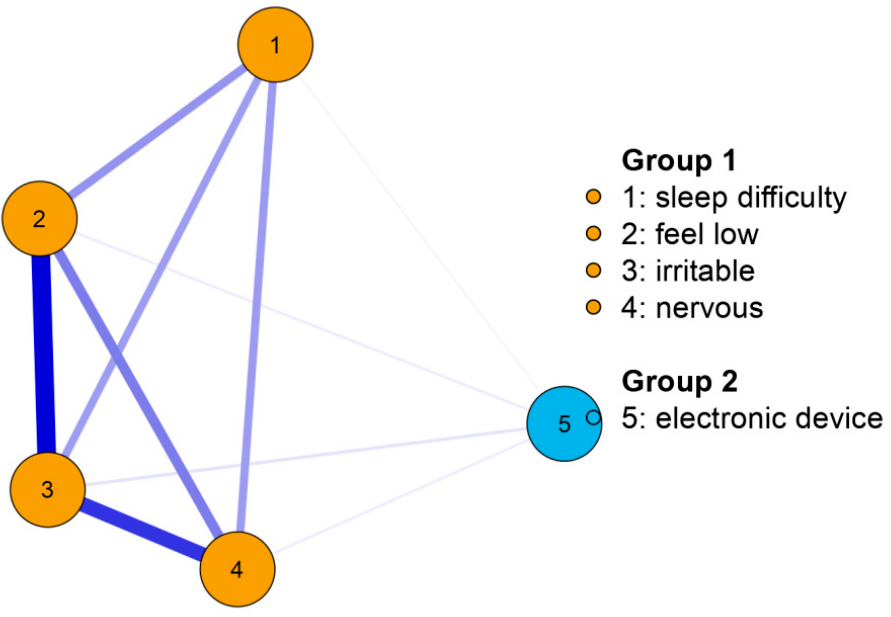
Figure 2. The network graph demonstrating the correlation between each psychological symptom and adolescents’ excessive electronic device use based on the 2014-year sample.